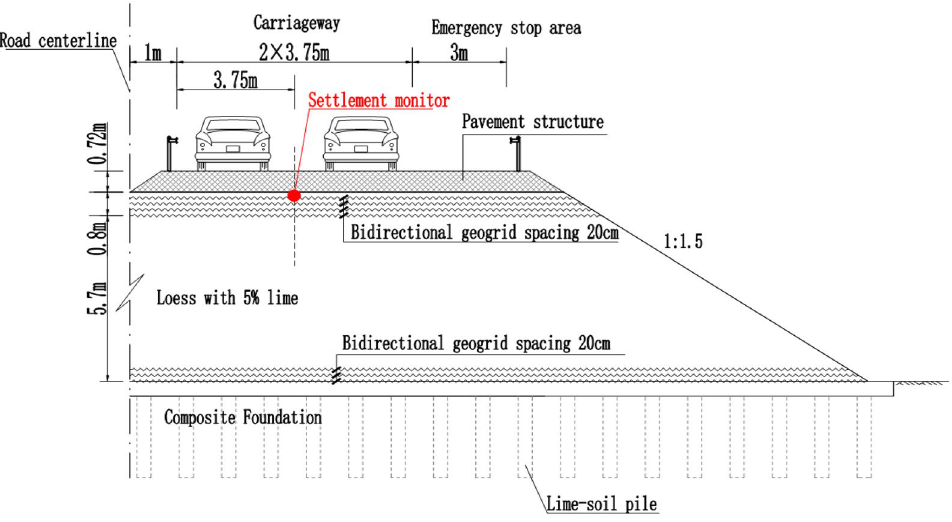
Figure 2. Cross-section of the